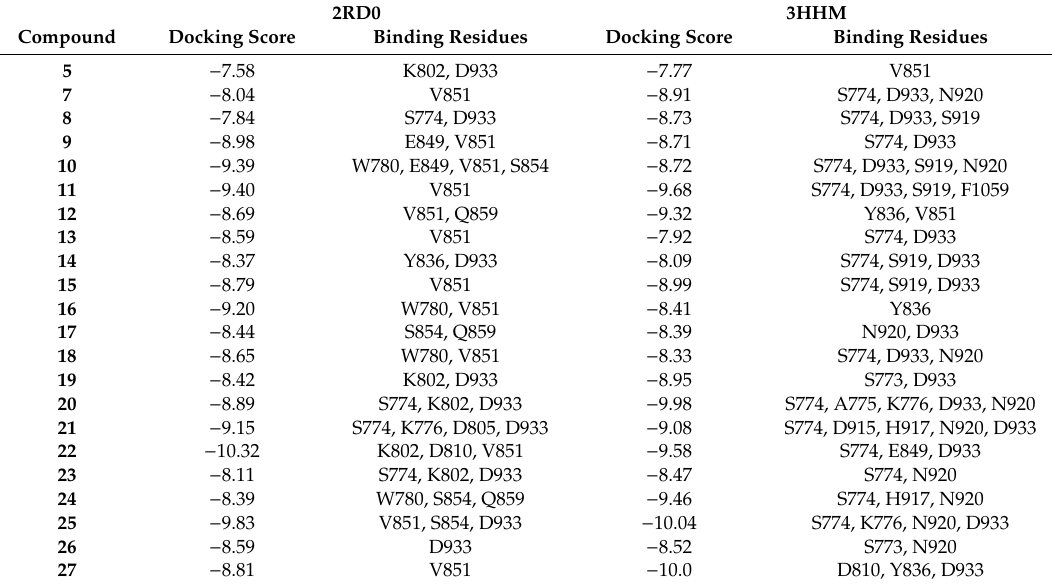
Figure 4. The kinase cleft of ( A ) 2RD0 bears the IF docked poses of some of the synthesized molecules and ( B ) overlaying of the IF docked conformation of 14 (represented in pink color) and the co-crystallized ligand (X6K) (yellow color). Some of key binding residues are disclosed and H atoms are unseen for clarification. Picture visualized by PYMOL [32]. Table 3. The IFD scores (Kcal / mol) and H-bond interactions between 2RD0 and